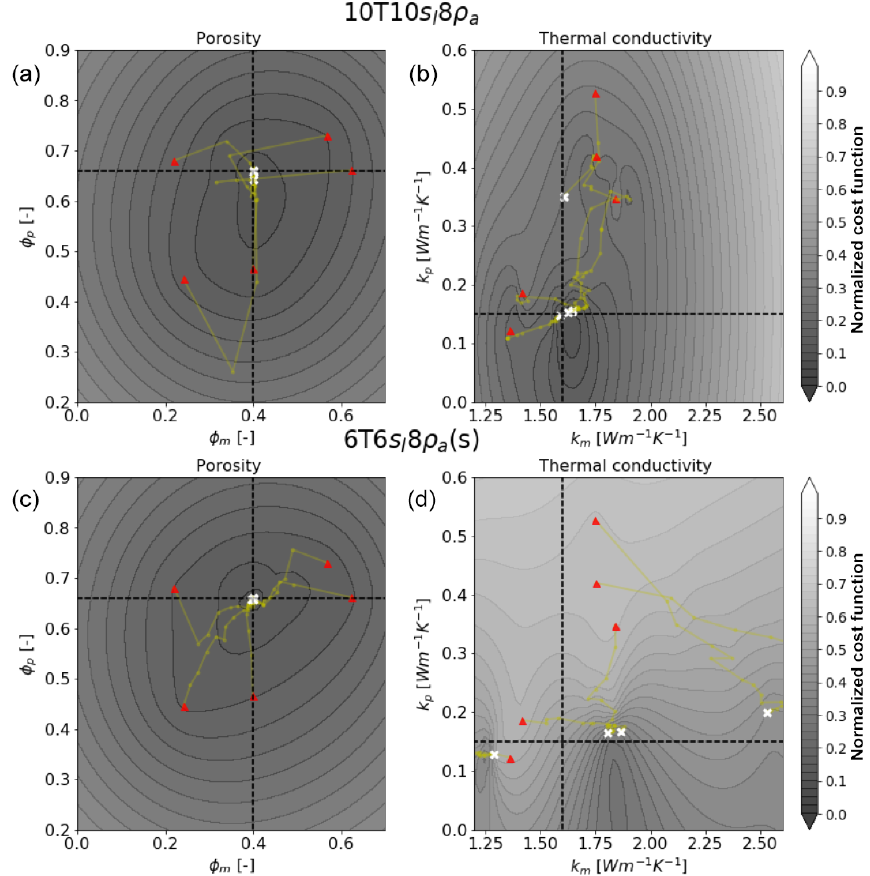
Figure 9. Estimated properties from five inversions of the two different cases: 10T10s l 8 ρ a (a) and 6T6s l 8 ρ a ( s ) (b) . The true values are shown as a cross section of the two dashed lines for the bulk porosities and effective thermal conductivities for peat and mineral soil layers. Yellow lines correspond to the paths taken by the LM algorithm. The white dots correspond to the estimated values. The columns from left to right correspond to the projection of the cost function with respect to porosities and thermal conductivities. The color bar represents the cost function normalized by its maximum logarithmic